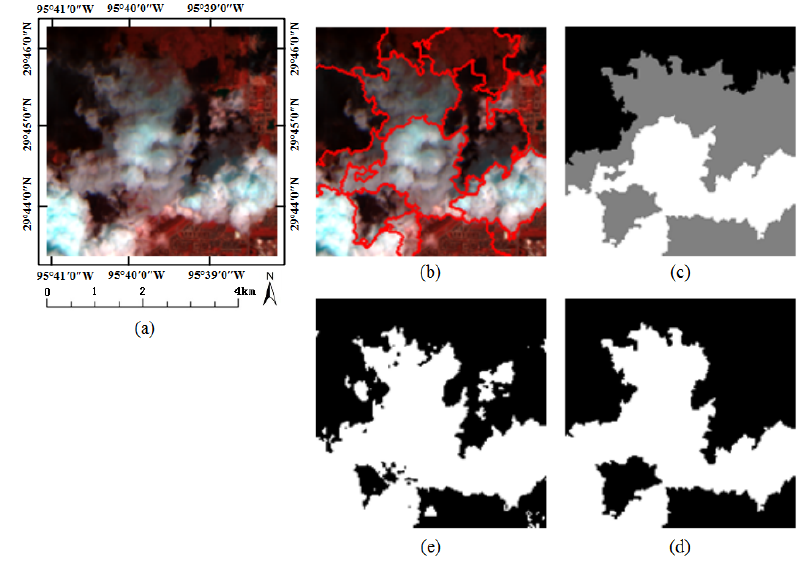
Figure 2. Example of superpixel segmentation. ( a ) Original color composite image. ( b ) SLIC segmentation result. ( c ) Superpixel coarse classification result (white represents the cloud, black represents the non-cloud and gray represents the potential cloud). ( d ) Two-step superpixel classification result. ( e ) Fully connected CRF refinement